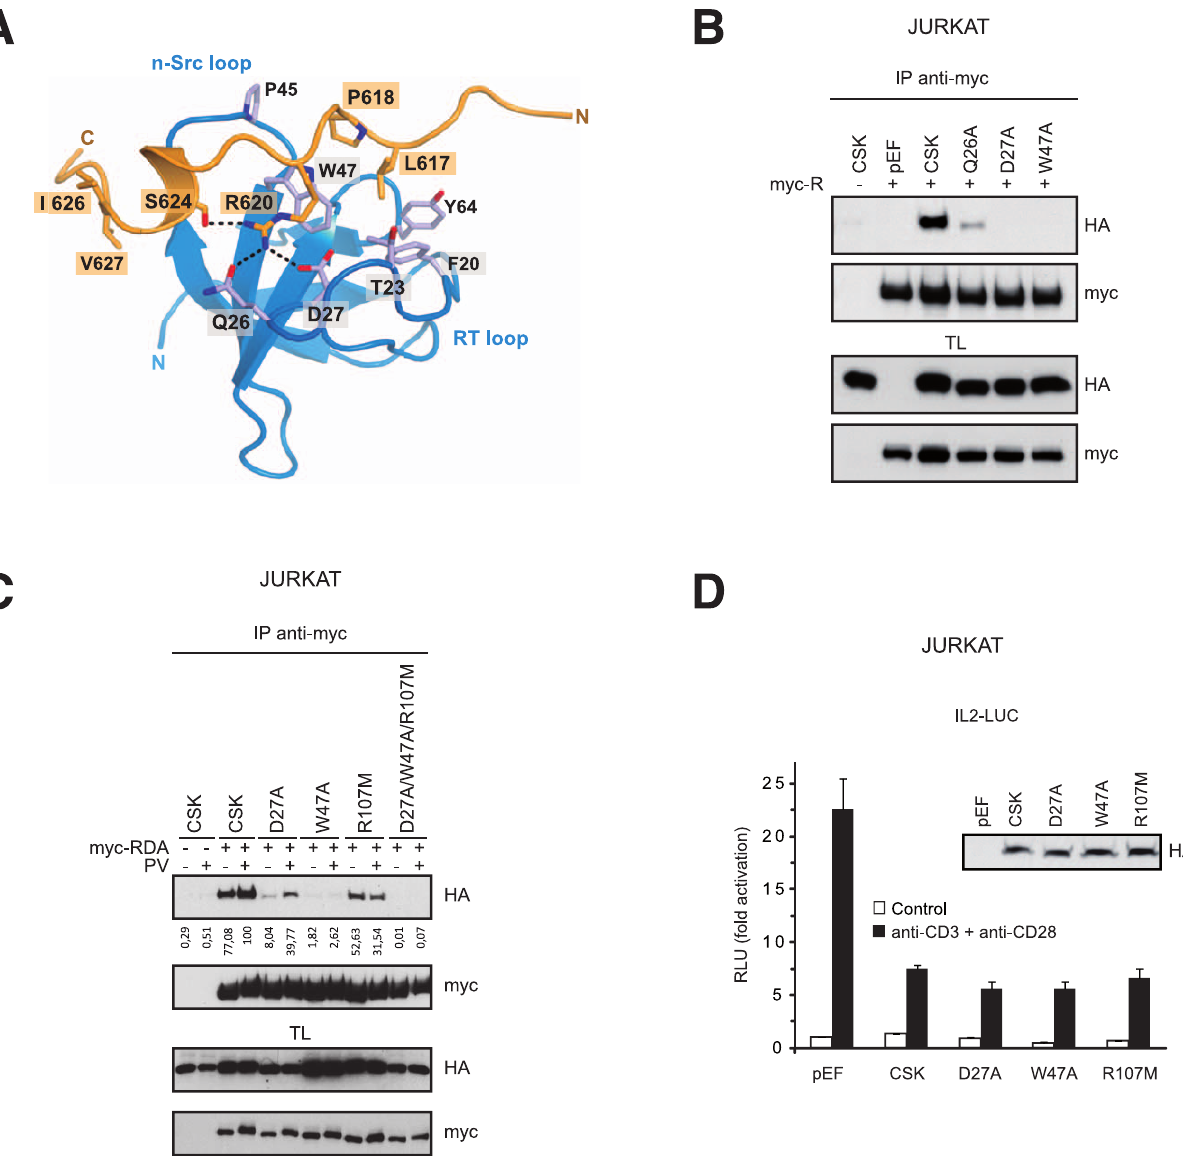
Figure 3. CSK SH3 and SH2 domains are involved in the association with LYP. A , Schematic representation of the NMR structure of the Pro rich motif P1 of Pep (orange) bound to the SH3 domain of CSK (blue) (PDB code 1JEG). P1 resid ues are numbered according to the LYP sequence (613IPPPLPVRTPESFIVVEE630). Arg620 is involved in intermolecular polar contacts with Asp27 and Gln26 of CSK; hydrogen bonds are shown by dashed lines. In addition, Arg620 could establish an intramolecular hydrogen bond with Ser624. B , Jurkat cells were electroporated with HA-CSK